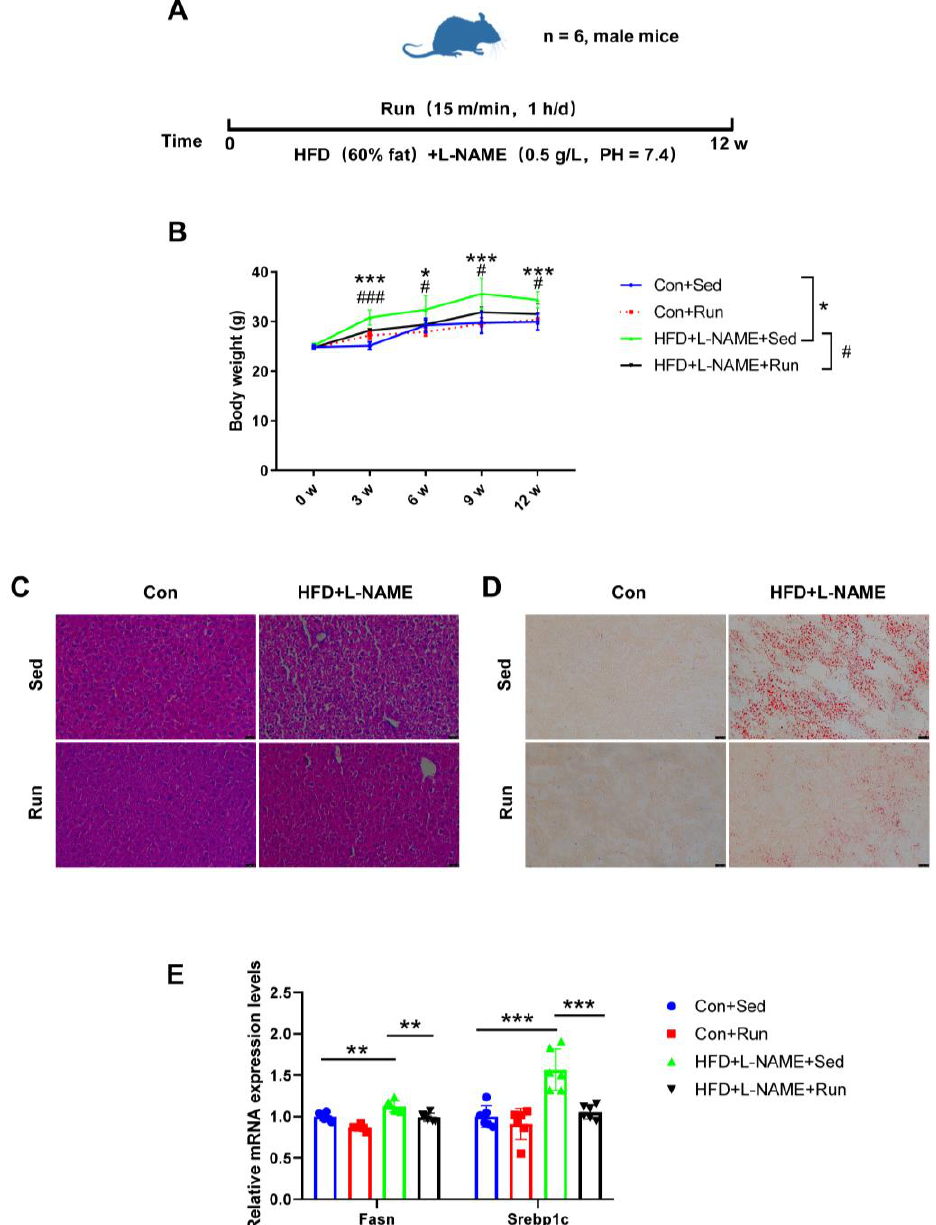
Figure 1. Exercise protects against liver steatosis in NAFLD mice. ( A ) The exercise schedule of NAFLD mice. ( B ) The body weight of mice. ( C ) The liver steatosis of mice determined by H&E staining. ( D ) The liver lipid content of mice detected by Oil Red O staining. ( E ) The mRNA levels of the genes related to liver lipogenesis (Fasn and Srebp1c) relative to GAPDH in the livers of mice. * p < 0.05, ** p < 0.01, *** p < 0.001; # p < 0.05, ### p < 0.001; n = 6. Sed, sedentary; HFD, high-fat diet; L-NAME, N ω -nitro-L-arginine methyl ester, hydrochloride; Fasn, fatty acid synthase; Srebp1c, sterol regulatory element binding protein-1c. Scale bar = 25 µ